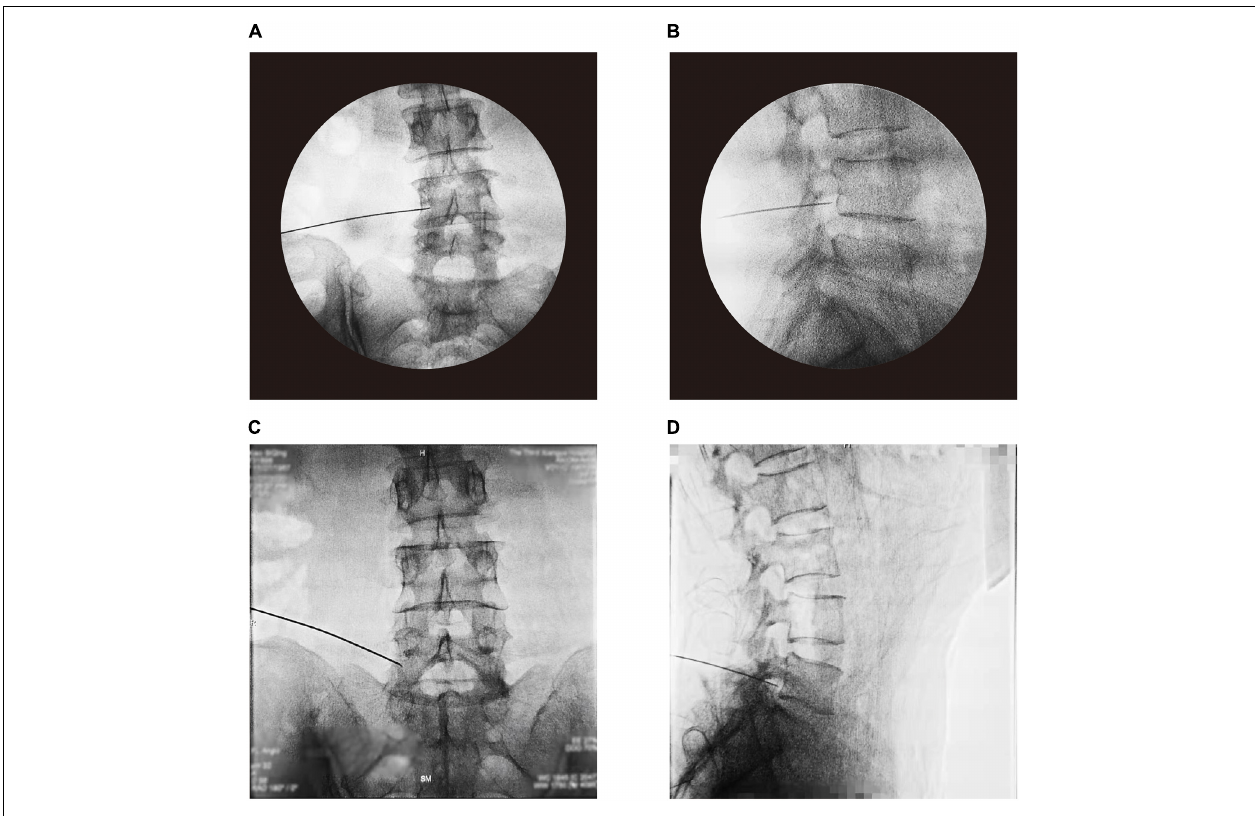
FIGURE 2 | Placement of PRF cannula confirmed by the guidance of C-arm fluoroscopy. Anterior-posterior and lateral view at L4 level (A,B) , and L5 level (C,D)